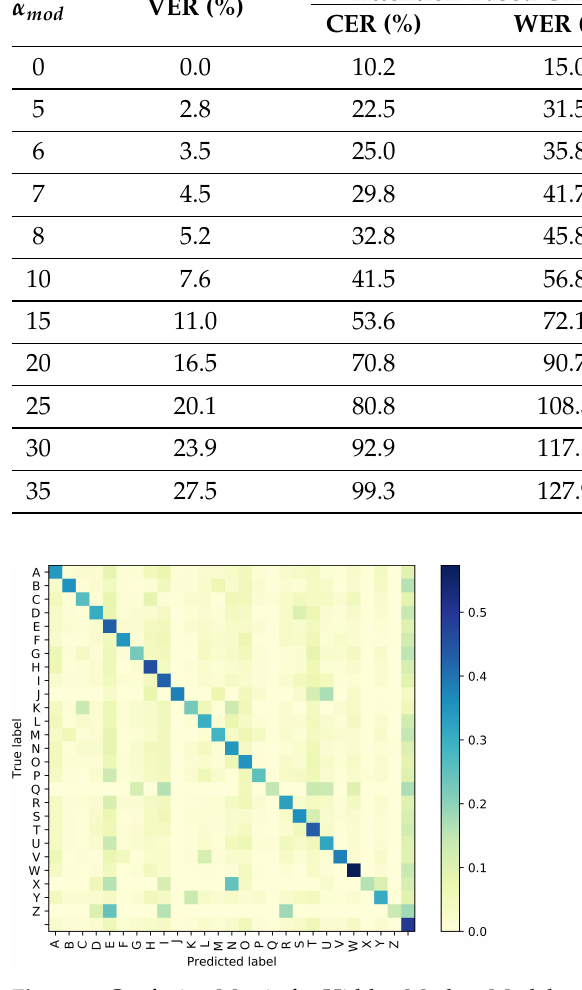
Figure 9. Confusion Matrix for Hidden Markov